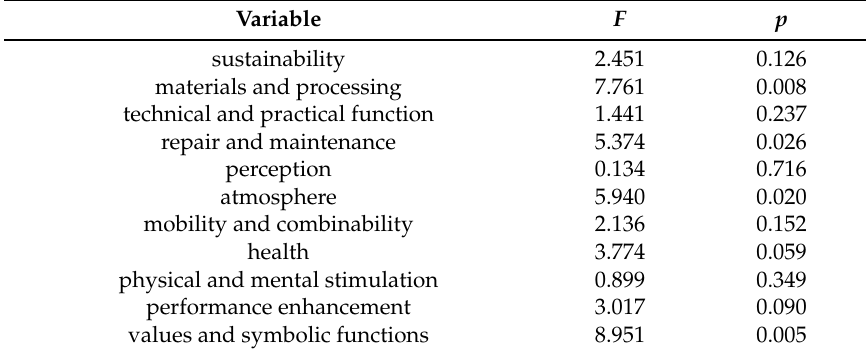
Table 1. F -values and p -values of the QCC-green for wood and laminate floor *. Variable